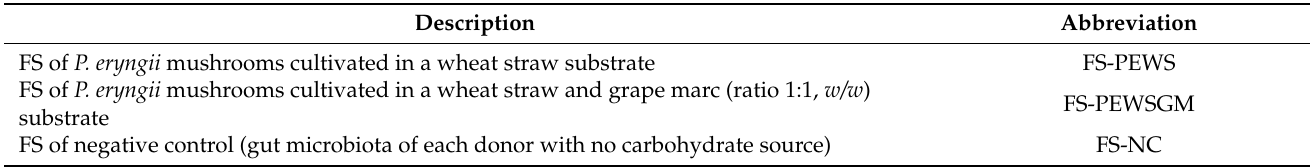
Table 1. Fermentation supernatants (FSs) used in the